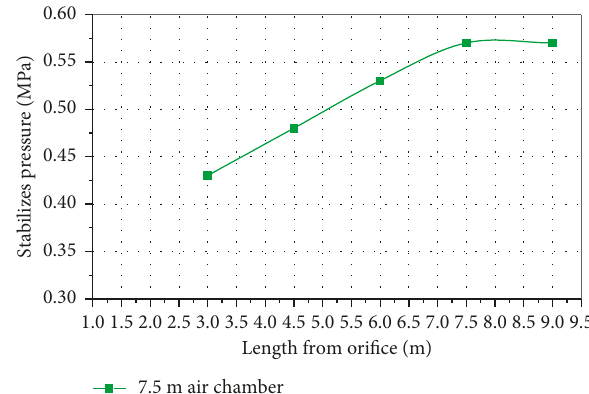
Figure 10: A diagram of the steady pressure change in the 7.5m gas